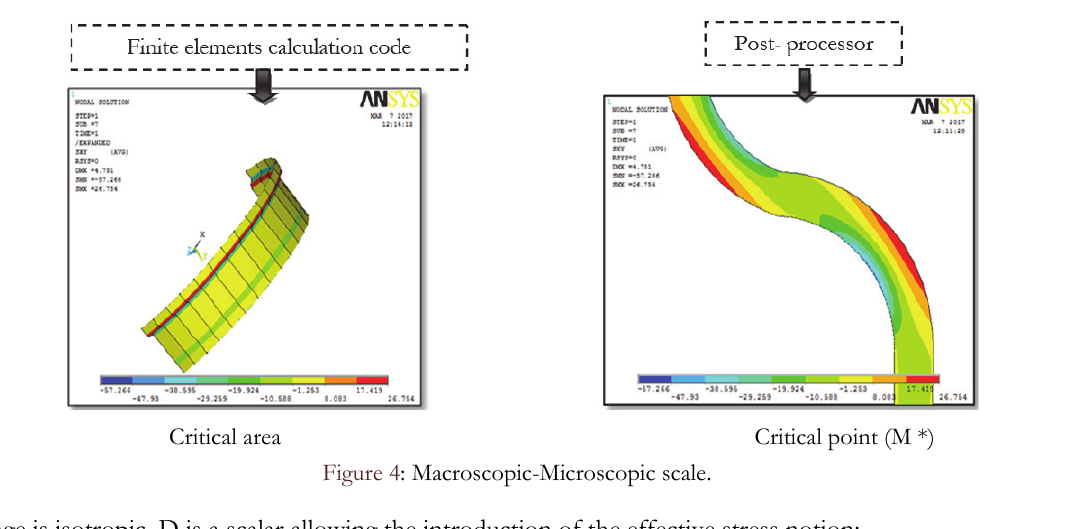
Figure 4: Macroscopic-Microscopic